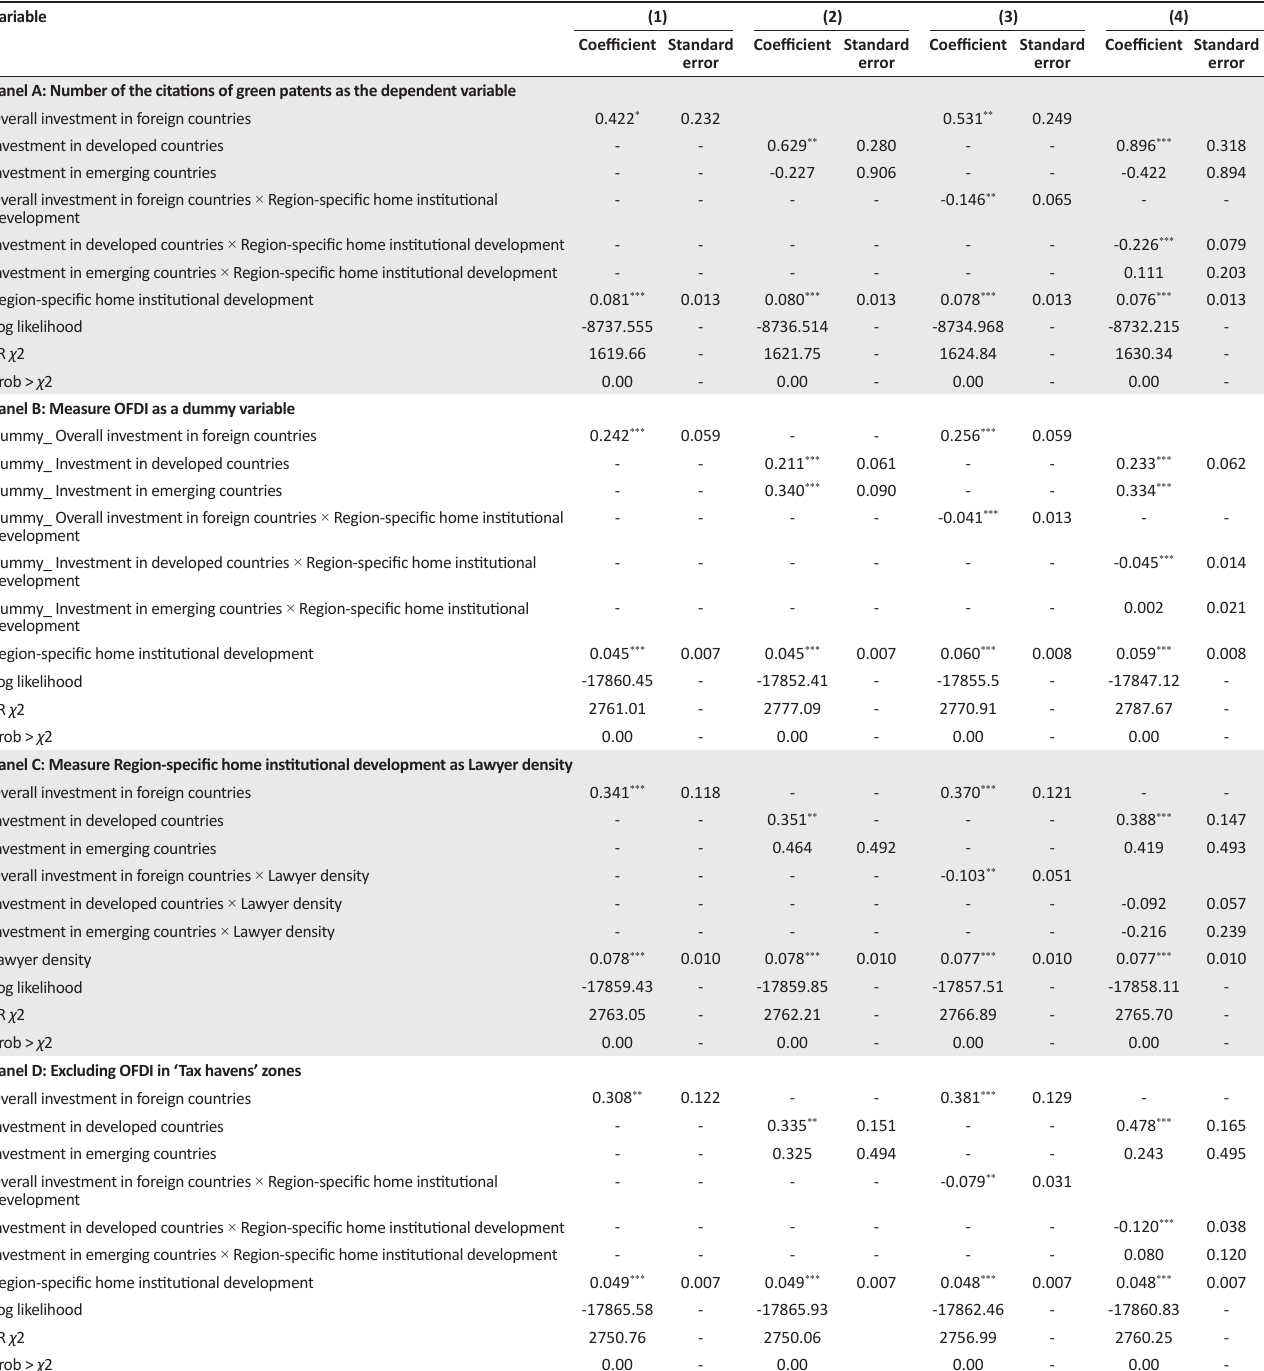
TABLE 3: Robust test ( N = 14 129).